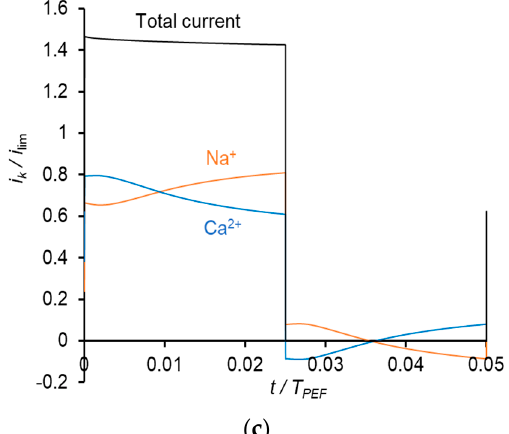
Figure 8. Dependences of normalized partial current densities of Na + and Ca 2+ ions on time in PEF mode at a frequency of 10 Hz and different U av : U av = 111 mV ( a ); U av = 150 mV ( b ) and U av = 238 mV ( c ).